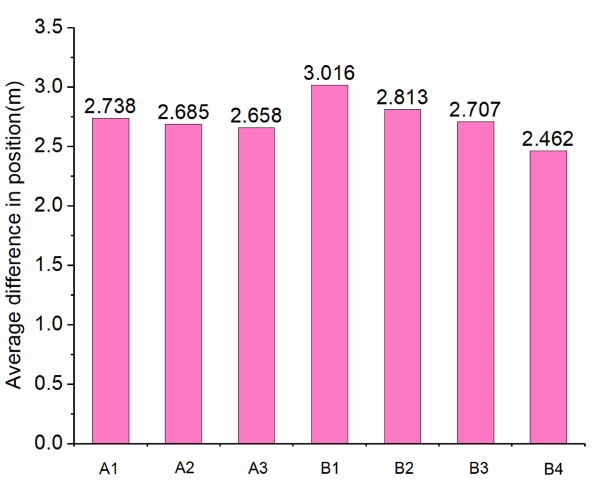
Figure 10. The difference in position with different kinds of orbit determination and arc